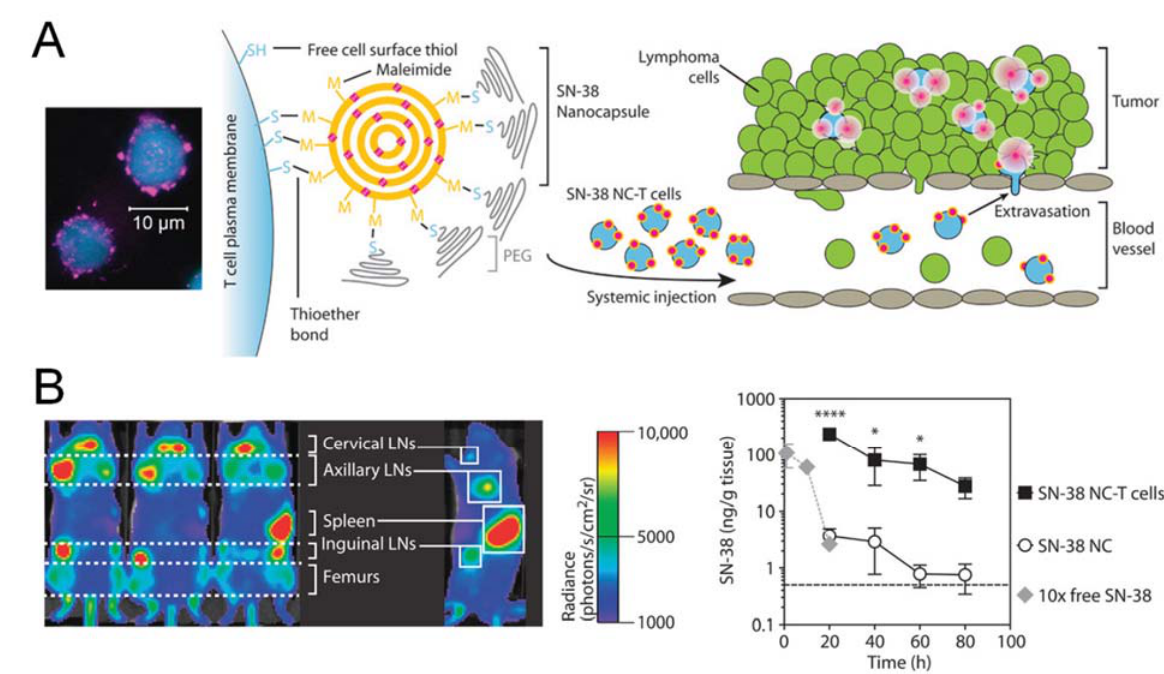
Figure 5. Engineered T cells for cancer therapy. ( A ) T cells (blue) conjugated with nanoparticles (magenta) loaded with a chemodrug (SN-38) were used for drug delivery to lymphoma; ( B ) T cells with surface-bound chemodrug preferentially accumulated in tumor-bearing lymphoid tissues following systemic administration, and significantly improved the drug distribution in lymph nodes, compared with equivalent or 10-fold higher dose of the nanoparticulate or soluble drug, respectively. Reproduced with permission